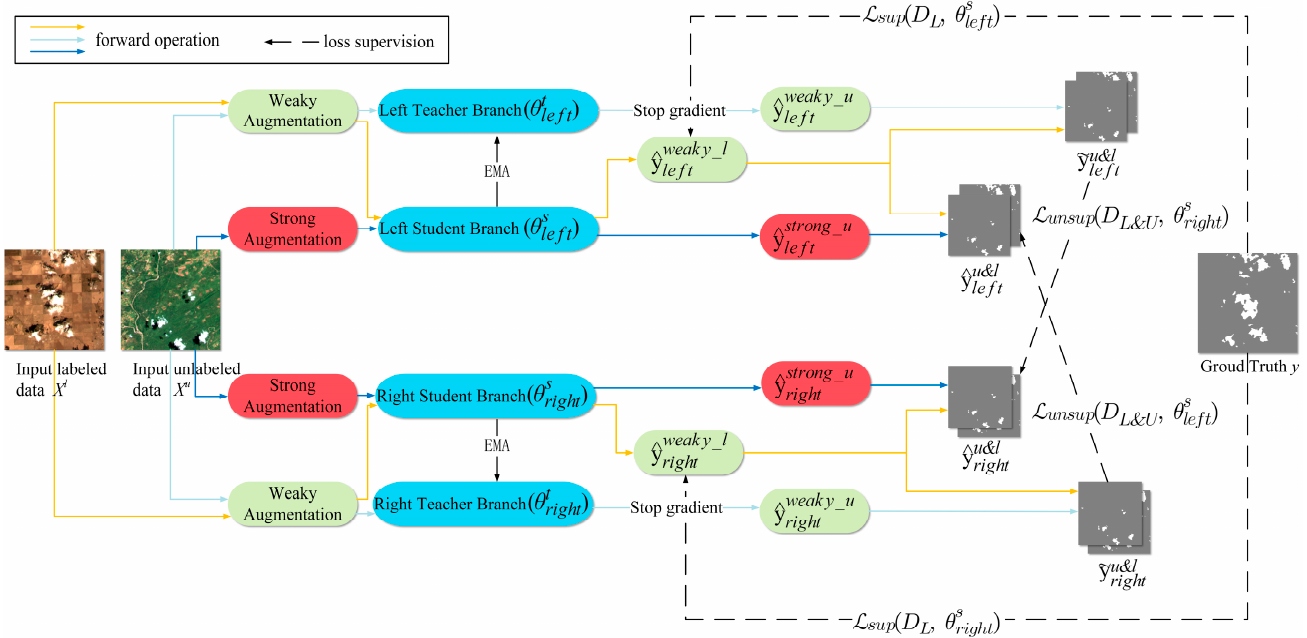
Figure 2. The architecture of the proposed method. Where the yellow direction arrow direction represents the processing work fl ow with labeled data, the dark blue arrow represents the processing work fl ow of unlabeled data after strong augmentation, and the light blue arrow represents the processing work fl ow of unlabeled data after weak augmentation.